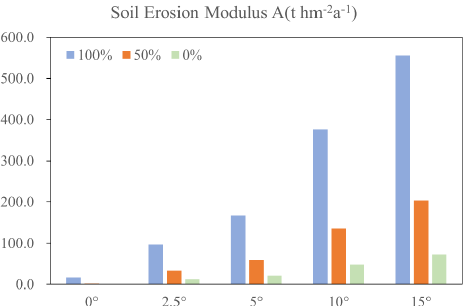
Figure 5. Effects of crop residue removal rates and land slope on soil erosion modulus A ( t ha − 1 a − 1 ). The bars show the mean values for each treatment. The numbers 0%, 50%, and 100% represent the crop residue removal rates for each treatment. Significant differences were observed among all treatments within each land slope ( p < 0.05).